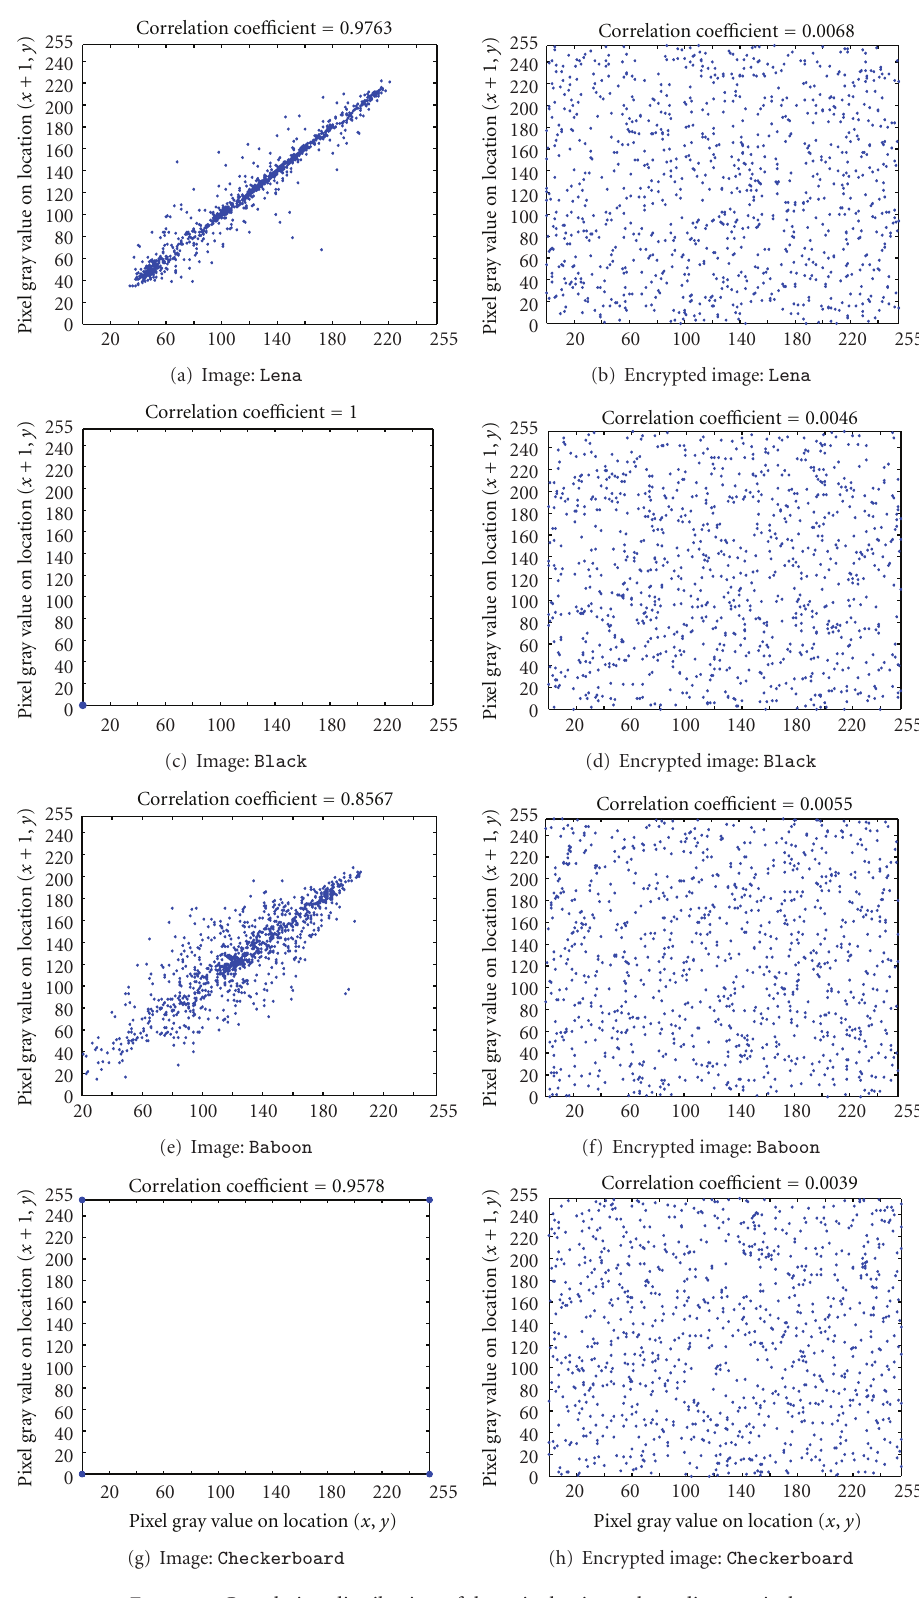
Figure 5: Correlation distribution of the pairs horizontal to adjacent